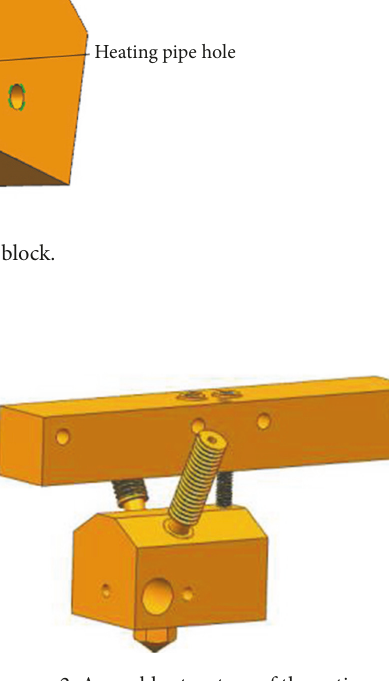
Figure 2: Assembly structure of the entire